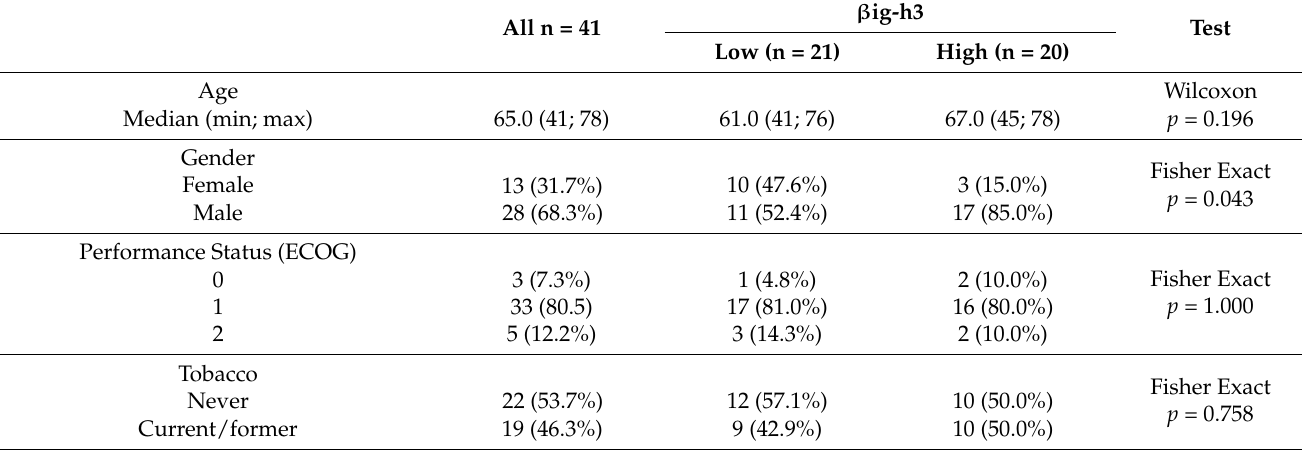
Table 1. Patient and tumor